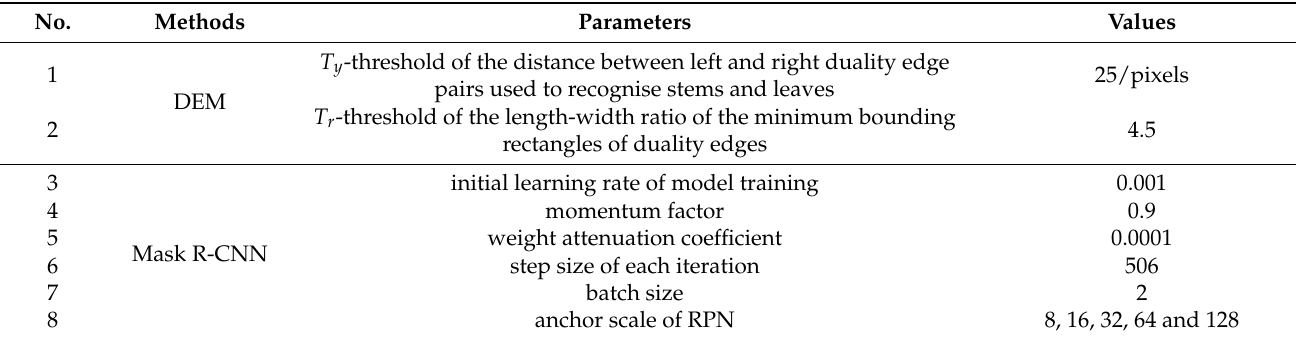
Table A1. List of parameters used in the study.